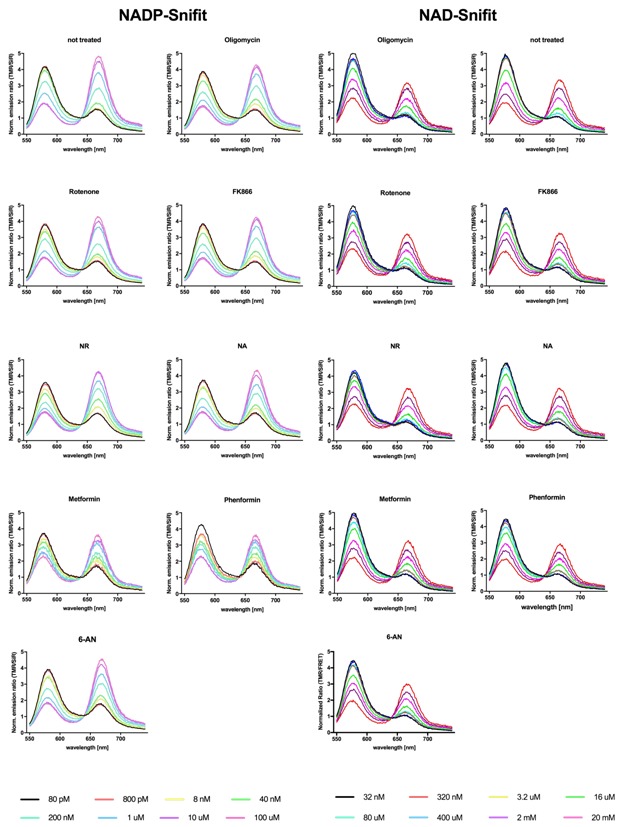
Emission spectra of the NAD(P)-Snifit titrates in the presence of investigated compounds.The emission spectra were recorded in the presence of the respective compound using the same conditions as for the FACS experiments. No significant alteration of the spectra was observed. Conditions: untreated control, 25 μM Oligomycin, 10 μM Rotenone, 100 nM FK866: (E)-N-[4-(1-benzoylpiperidin-4-yl)butyl]−3-(pyridine-3-yl)acrylamide, 10 mM NR: nicotinamide riboside, 1 mM NA: nicotinic acid, 1 mM Metformin, 1 mM Phenformin.